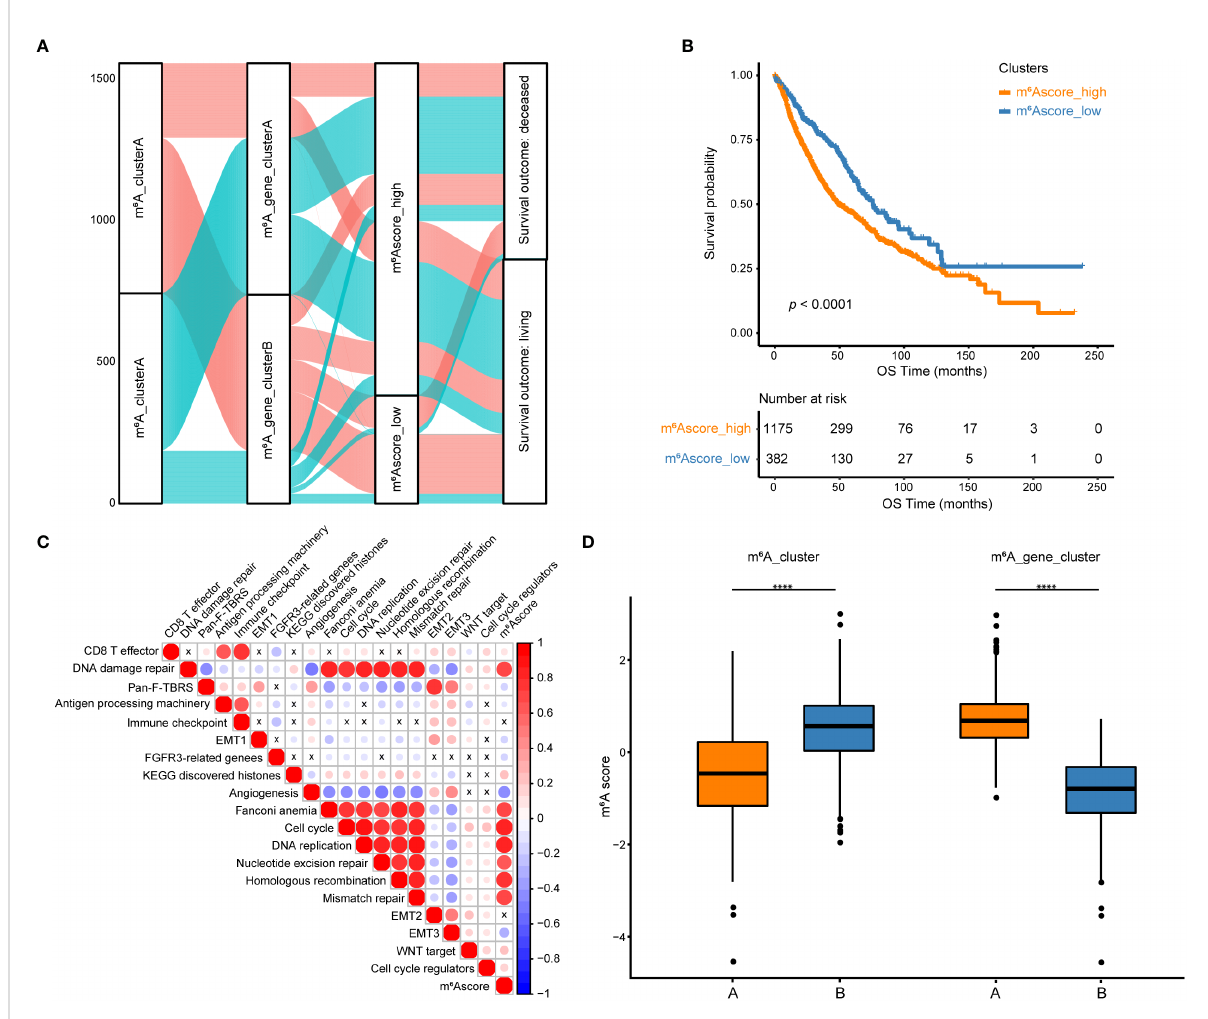
GSVA and Pearson correlation analysis show correlations between m 6 Ascore and biological pathways constructed with known gene signatures in NSCLC. A positive correlation is indicated by red, while a negative correlation is indicated by blue. The circle size is inversely proportional to the levels of signi fi cance, and X indicates no signi fi cant correlation. (D) Boxplots show the differences in m 6 A scores between m 6 A clusters and between m 6 A gene clusters. **** p <